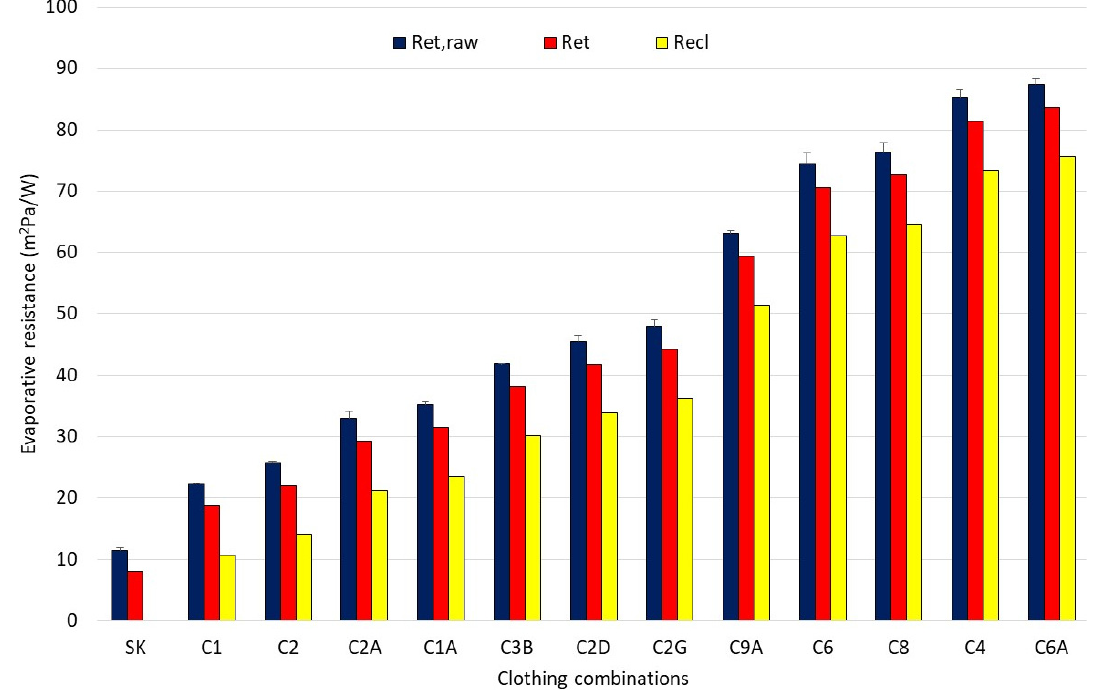
Figure A2. Measured (Icl (meas)) and summed (Icl (sum, ISO 9920)) basic clothing insulation of all ensembles ( I cl , clo) with their relative differences (Diff(%)). For clothing combination descriptions see Tables 1–3.